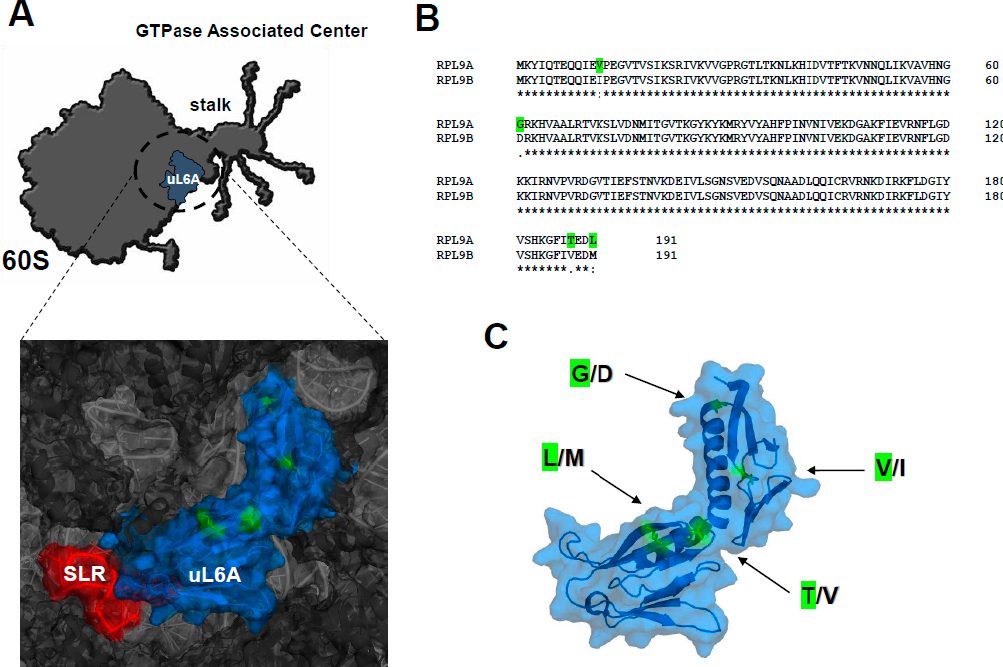
Figure 1. Structural overview of yeast ribosomal uL6A and uL6B proteins. ( A ) Model showing the position of the uL6A protein within the GTPase-associated center in the 60S subunit; S. cerevisiae 26 S rRNA (PDB code 3U5H) and proteins (PDB code 3U5I) from the 60S subunit are indicated as light gray and dark gray colors, respectively. The fitted schematic structure of the uL6A protein is marked in blue. The positions of mutated amino acids are marked in green. The sarcin-ricin loop (SRL) is marked in red. The stalk depicts the position of ribosomal P-proteins and uL10. ( B ) Amino acid sequence alignment of uL6A and uL6B proteins [36]. ( C ) Structural model of the uL6A protein with marked mutations positions.